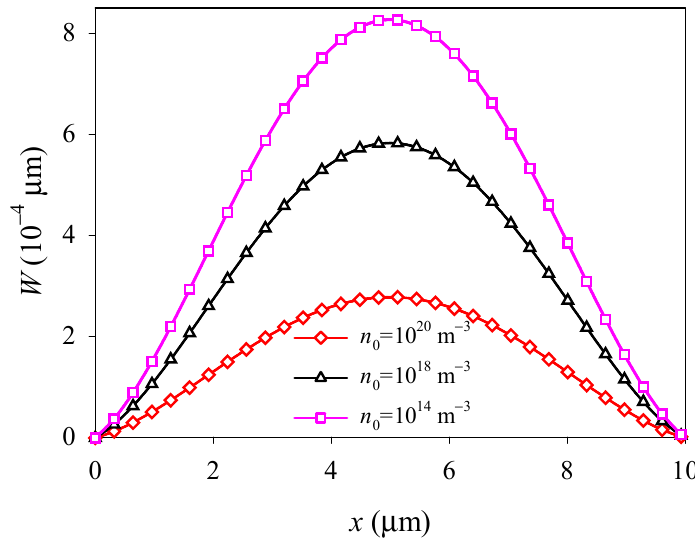
Figure 6. Deflection W along the midline y = d /2 versus initial electron concentration n 0 .